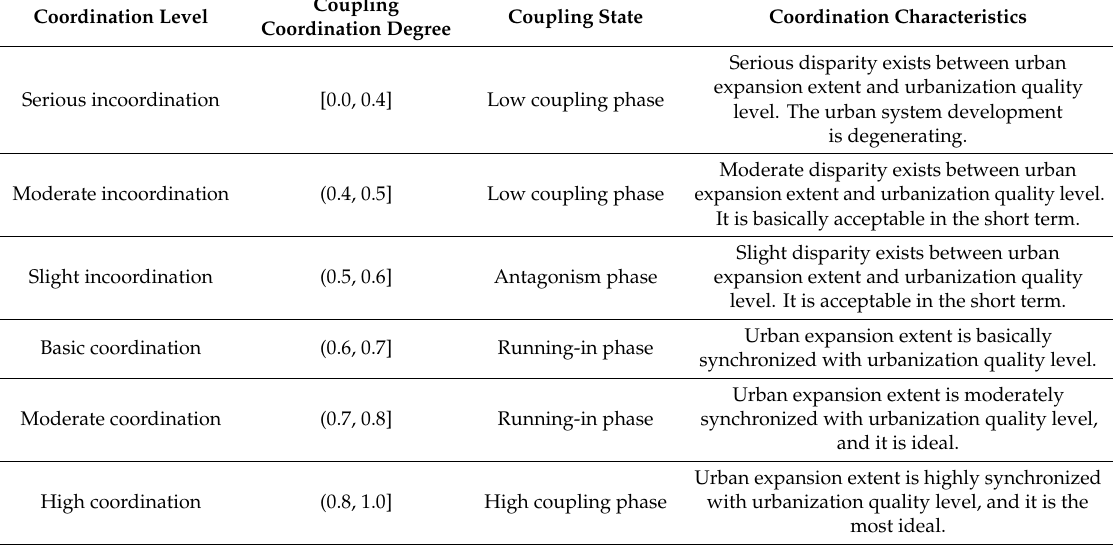
Table 3. Classification type of coupling coordination degree between urban sprawl and urbanization